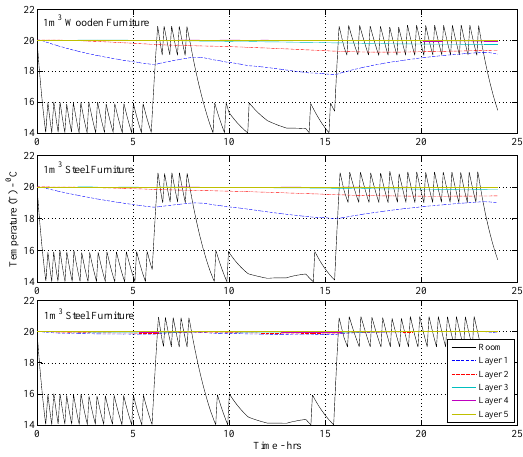
Figure 7: Temperature variations across the spheri- cal furniture element and room temperature